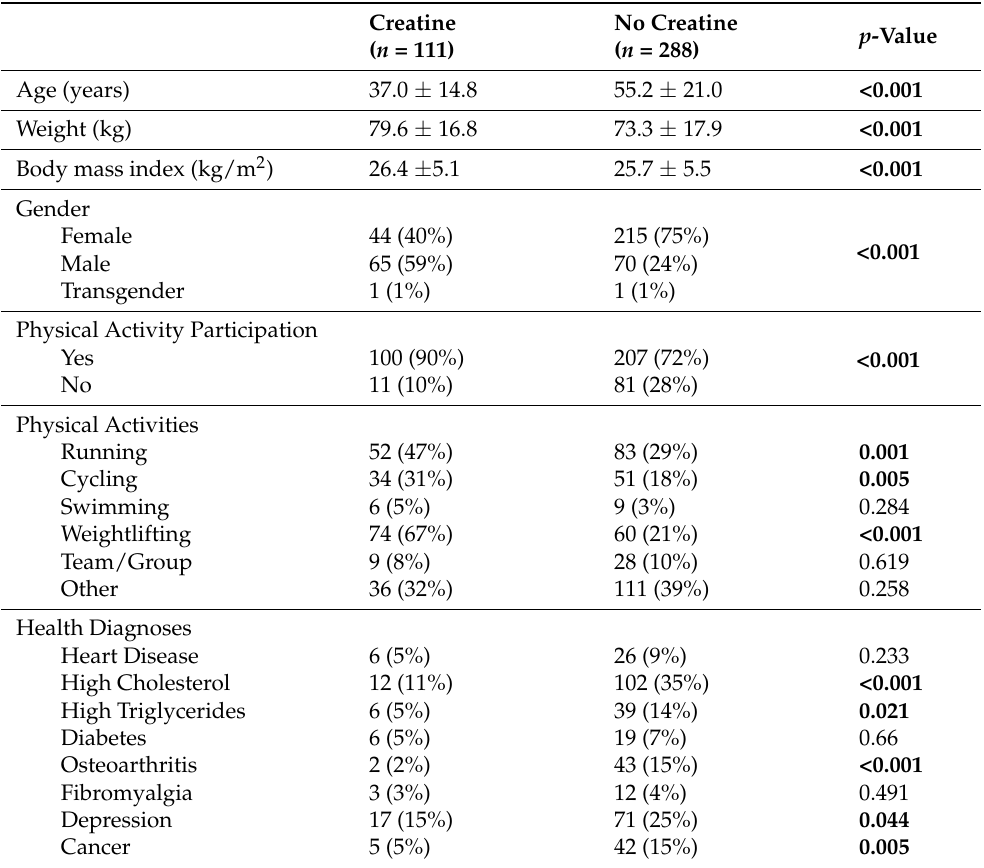
Table 2. Between-group comparison of respondents based on use of